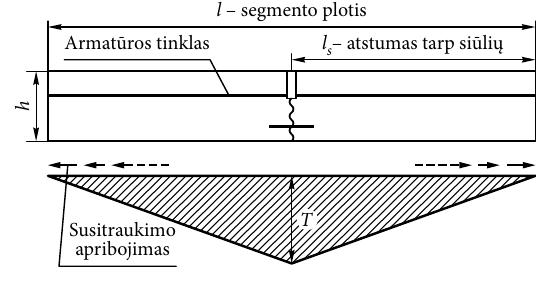
Armat(cid:31)ros